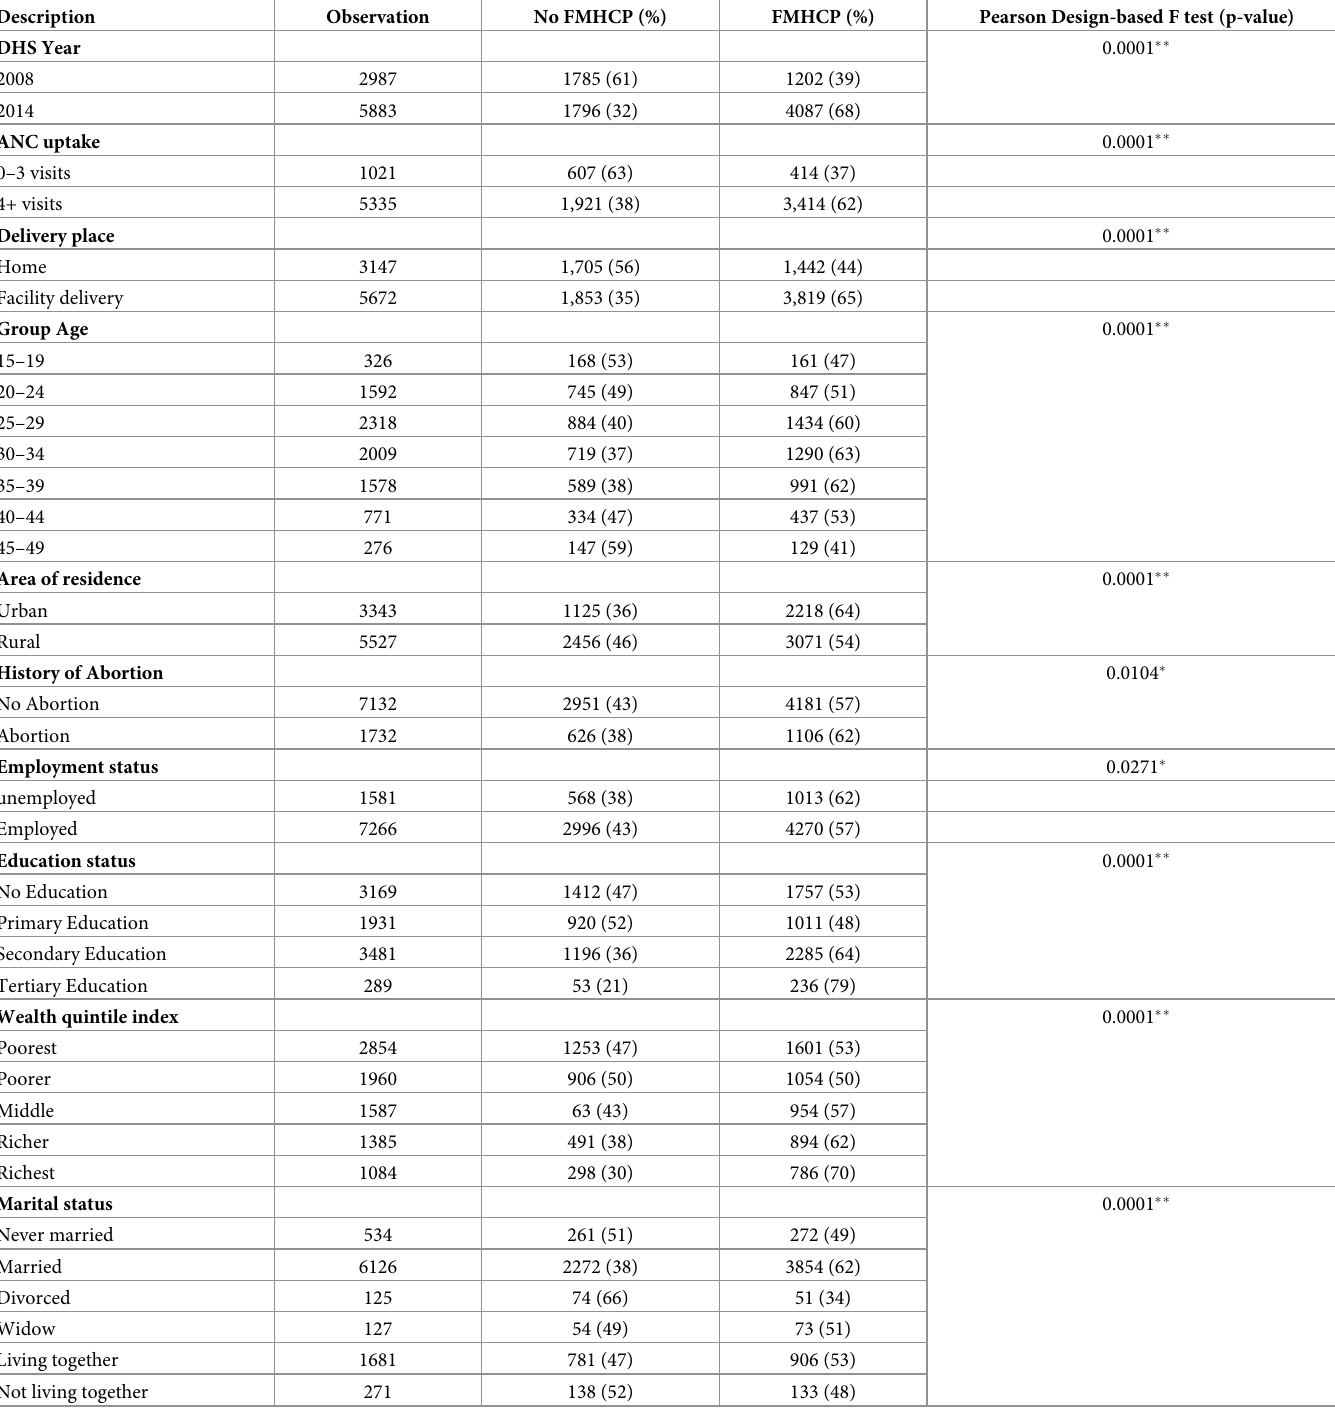
Table 4. Distribution of maternal characteristics between the ‘free’ maternal health policy and the no ‘free’ maternal health care policy